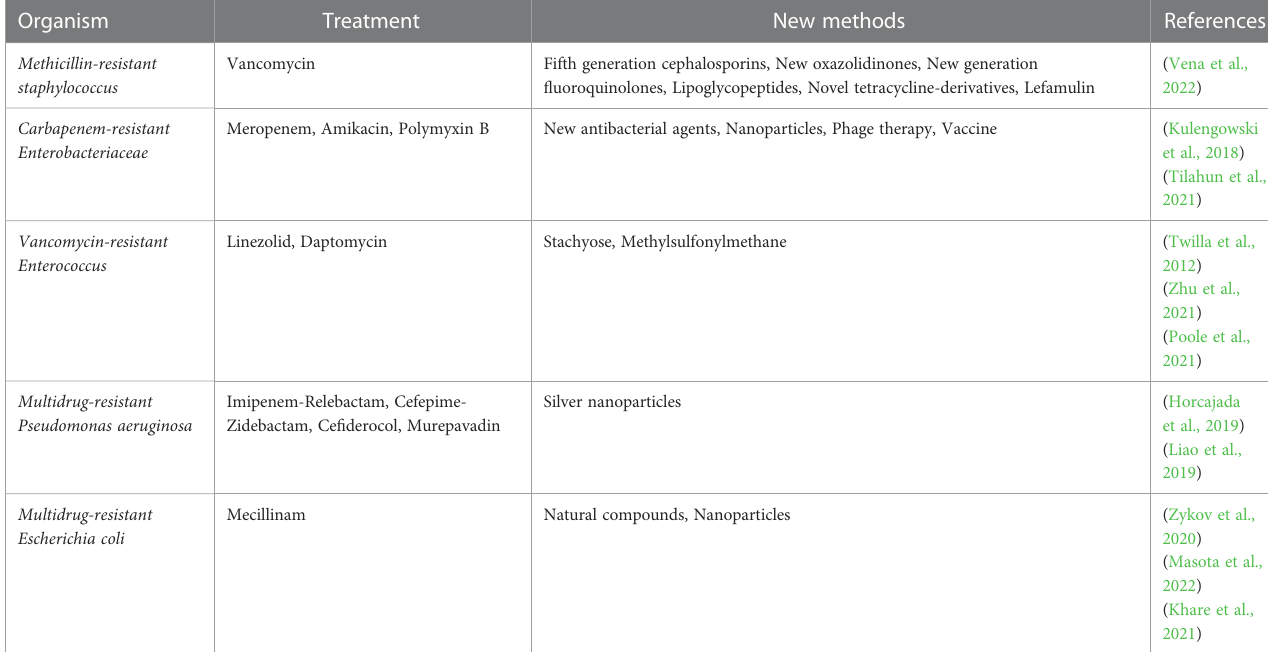
TABLE 2 Treatment methods and new methods of drug-resistant bacteria. Organism